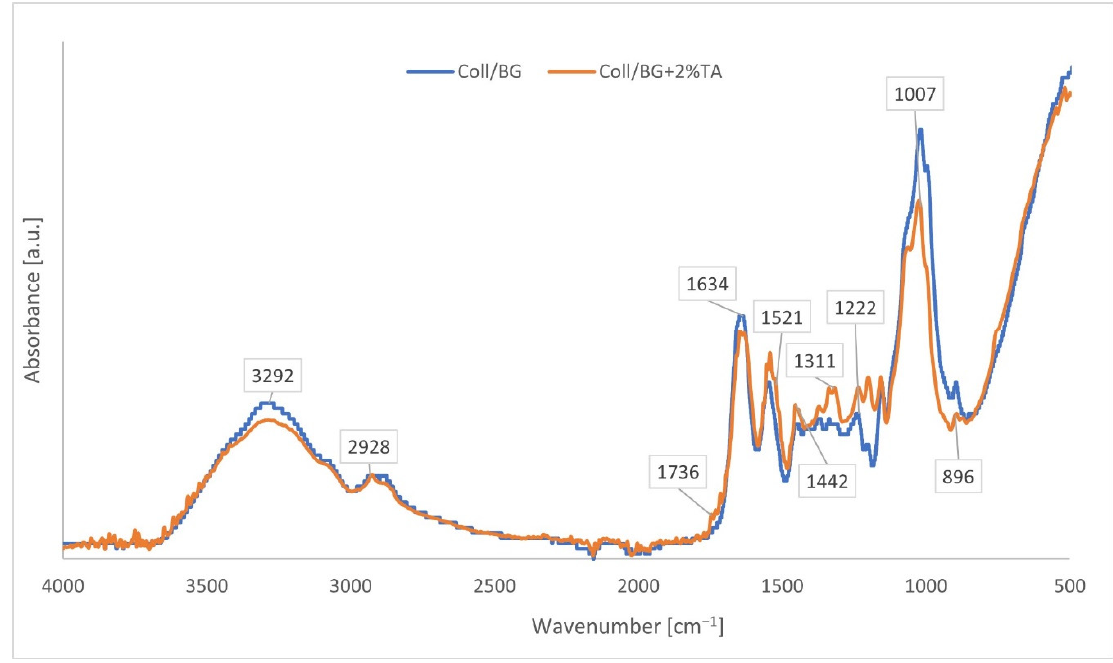
Figure 2. ATR-IR spectra for Coll/BG with 2 wt.% of tannic acid (Coll/BG + 2%TA) and without it. Additionally, a small peak at 1736 cm − 1 was observed that indicated the presence of a carboxyl carbonyl group. The peak at 1442 cm − 1 implied the deformation of –C–C– in the phenolic groups, while the band at 1311 cm − 1 was due to the presence of an aromatic group –C–O. ATR-FTIR spectra of Coll/BG crosslinked with tannic acid showed a shift towards higher values from 1521 to 1539 cm − 1 that corresponded to NH 2 bond stretching (Amide II). 3.2. Mechanical Properties The results of mechanical parameters tests are presented in Figure 3. Although some increase in the comprehensive modulus (E mod, Figure 3a) with the increase in tannic acid content could be noticed in some samples, these differences were not statistically signifi- cant ( p <0.05). The maximum tension ( σ max, Figure 3b) increased after the addition of 10% of tannic acid, but this was not statistically significant ( p > 0.05). Additionally, no statisti- cally significant changes in the maximum tension values were observed for hydrogels with 2% and 5% TA.